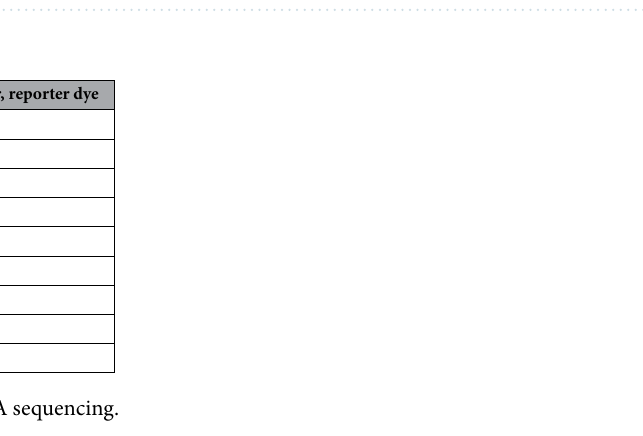
Table 1. Master mix reagents for qRT-PCR.